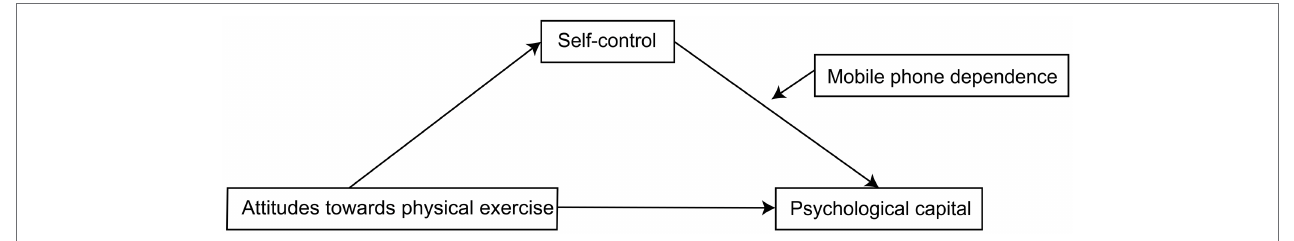
FIGURE 1 | Relationships among the concepts of the